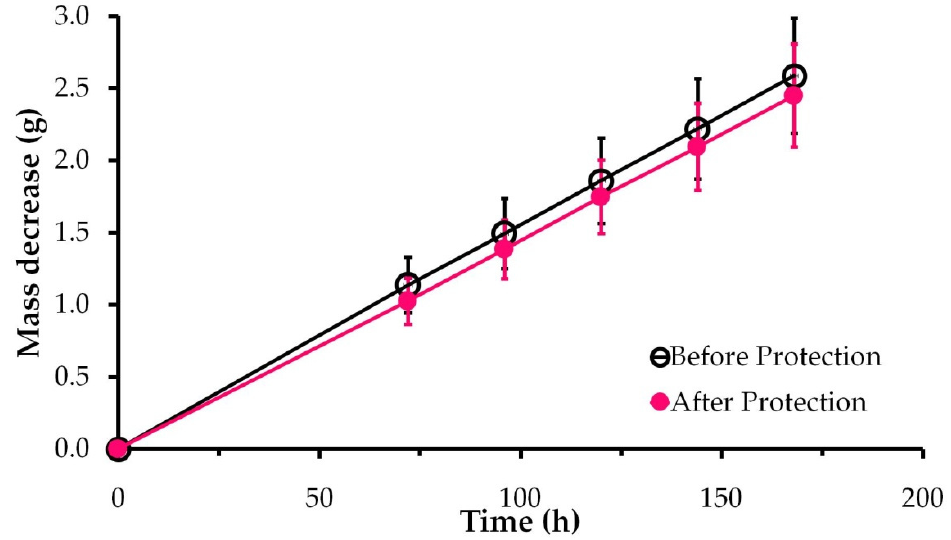
Figure 4. Mass decrease, as a function of time, measured during the water vapor permeability test. Table 4. Water vapor flow rate (G) and water vapor transmission rate (WVTR) in the untreated and protected stone samples; the reduction of the vapor permeability (RVP) after the protective treatment is also